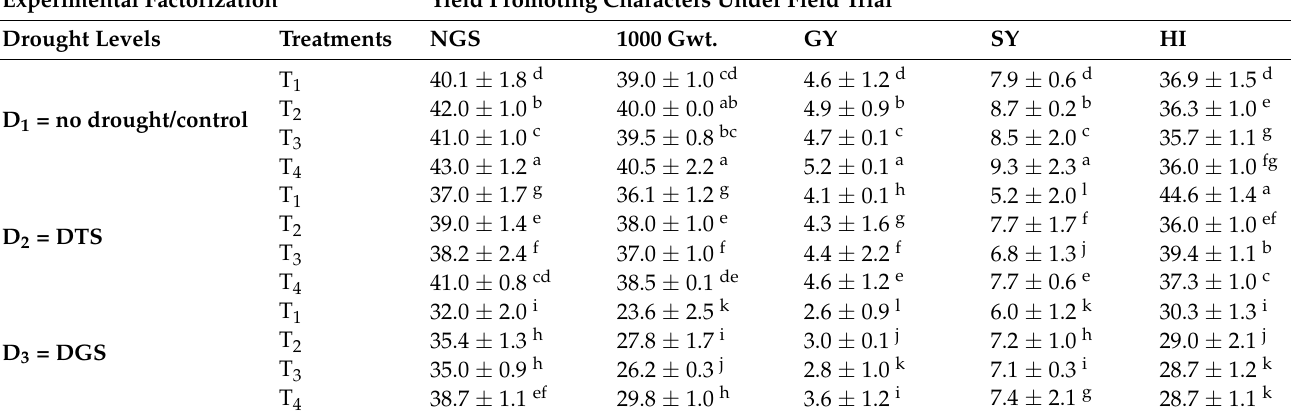
Table 2. Drought-ameliorating effects of PGPR and ZnO nanoparticles on number of grains (NGS), 1000 grain weight (1000 Gwt. g), grain yield (T ha − 1 ), straw yield (SY, T ha − 1 ), and harvest index (HI,%) of wheat under different drought